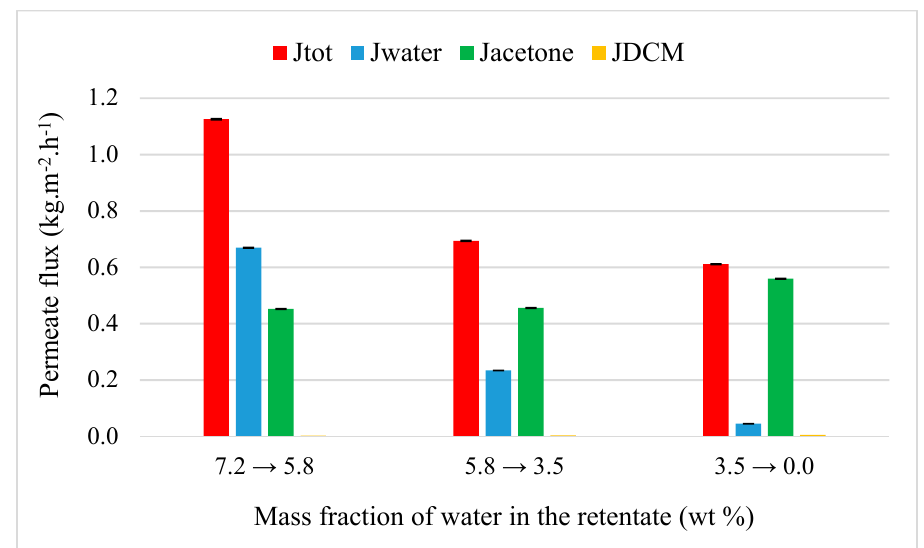
Figure 9. Evolution of flux as the function of the inlet water composition from a ternary acetone-water -DCM mixture (90.8/7.2/2.0 wt%) through M1 at 50 °C. Membranes 2019 , 9 , x FOR PEER REVIEW